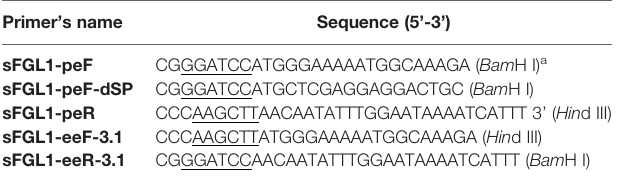
TABLE 1 | Primers used in this